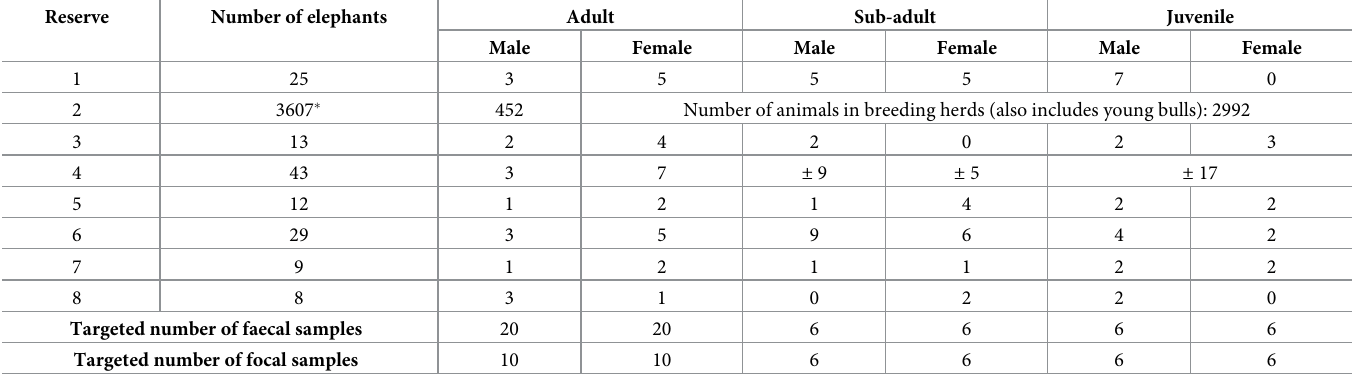
Table 5. Reserves with the number of study individuals that fall into the targeted age groups and sexes that could lead to multiple focal and faecal samples of the same elephant. Reserve